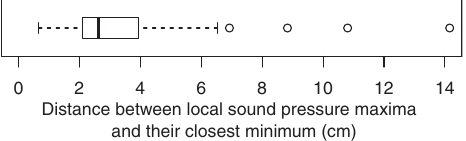
Figure 12. Distance of local sound pressure maxima to their closest local sound pressure minimum. Analysis of Figure